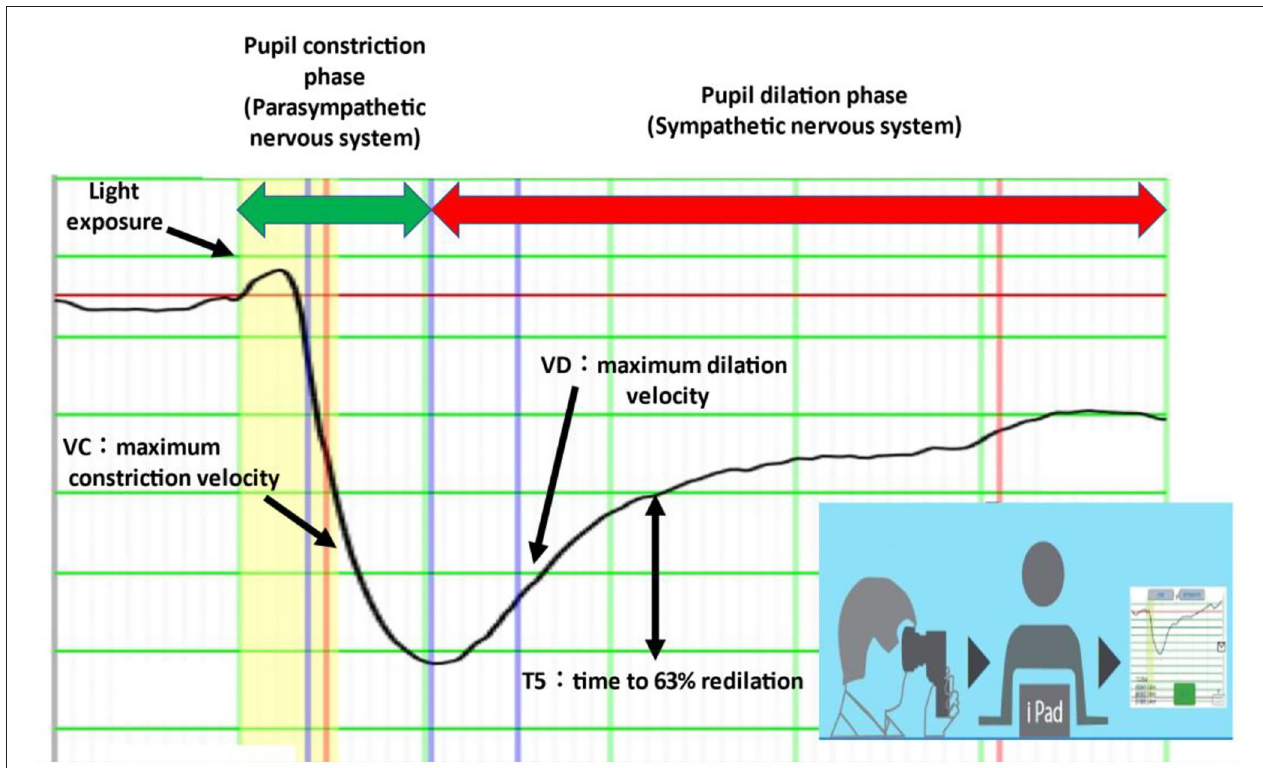
FIGURE 1 | Electronic pupillometry. VD and T5 represent sympathetic activity and VC represents parasympathetic activity. The measuring device is portable and can be connected to an iPad via Wi-Fi. Each measurement takes less than 1min.